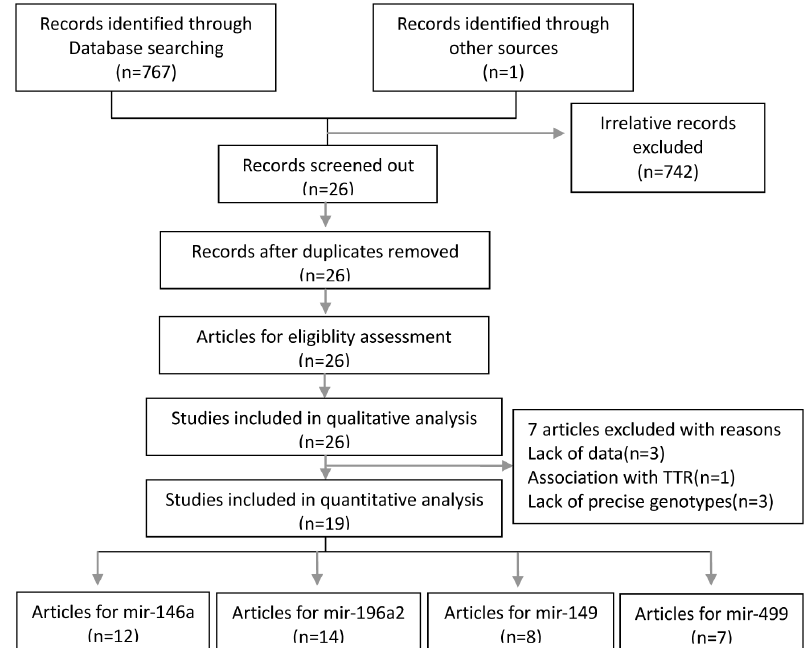
Figure 1. The flowchart of the selection process. We utilized a comprehensive searching strategy to screen out potential related articles as far as possible. 26 articles focusing on the association between the four genetic polymorphisms and cancer prognosis are screened out. 7 articles are excluded in quantitative ananlysis for lack of data to calculate pooled HR and 95%CI.